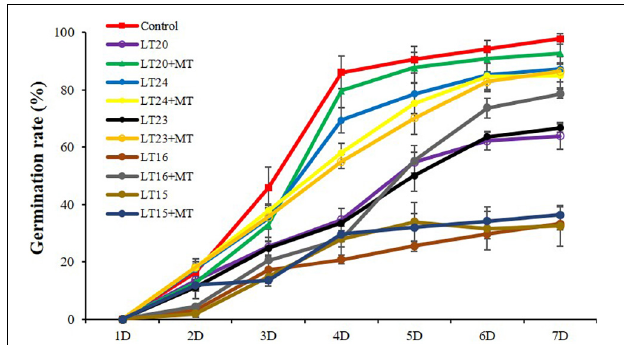
FIGURE 2 | Effects of exogenous MT treatment on the seed germination performance under LT stress. (A) Phenotypes, (B) germination percentage, and healthy seedling rates under LT stress (constant 20 ◦ C for 7 days) without (LT20) or with (LT20 + MT) MT treatment. Different letters denote significant variations between the treatments, and the average values were measured by Tukey’s honestly significant difference (HSD) test at p < 0.05. Data were represented as mean ± SE of six biological